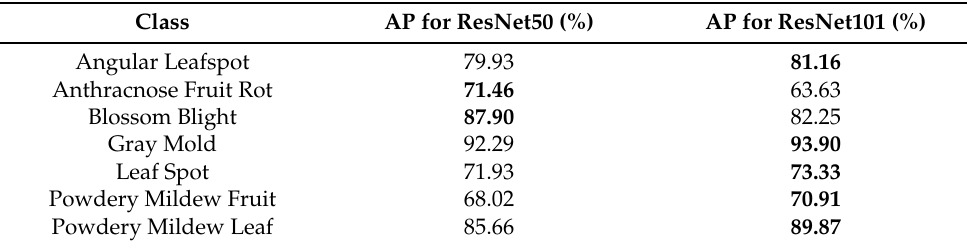
Table 8. Per-class Average Precicion for